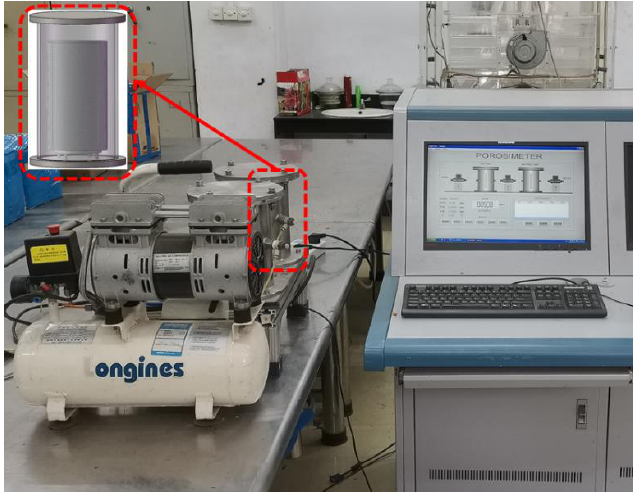
Figure 4. Experimental apparatus for measuring the porosity.